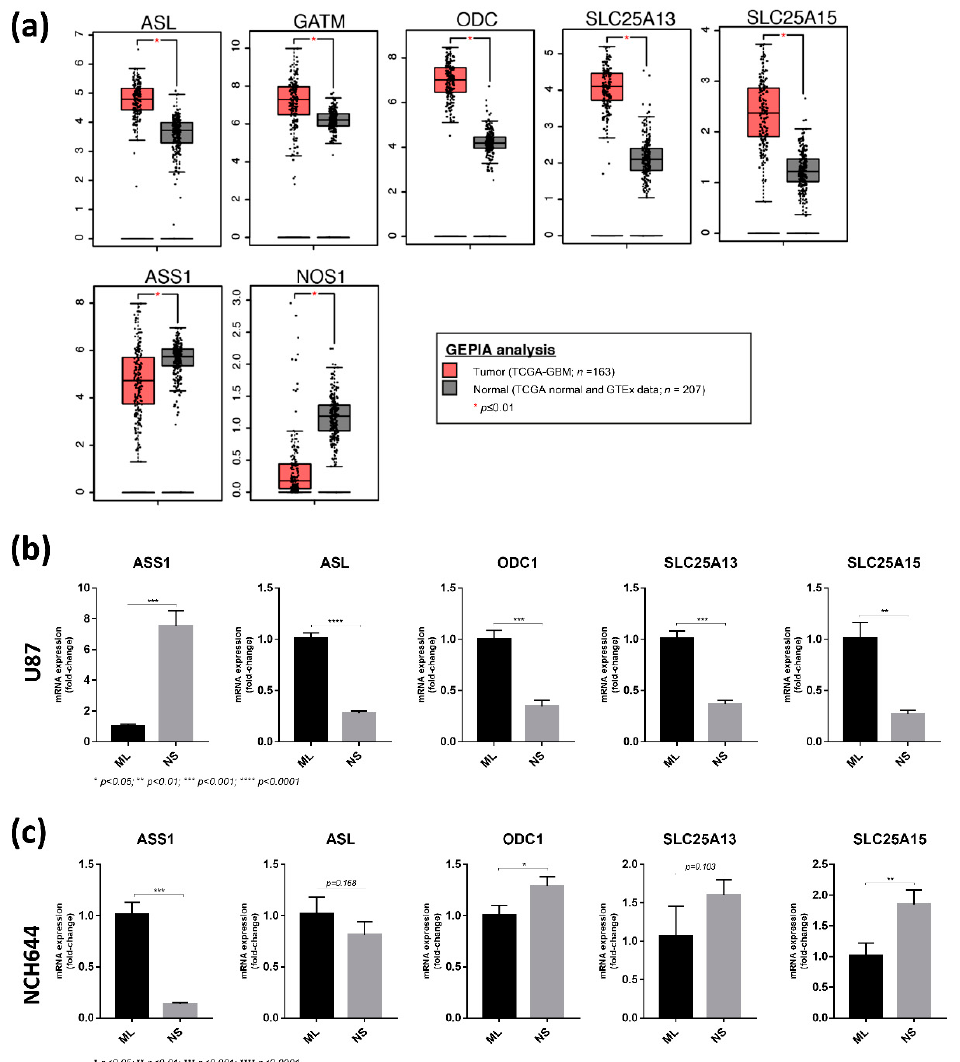
Figure 6. Expression analysis of arginine biosynthesis genes in NCH644 NS compared to ML cells may resemble human GBM tumours compared to normal tissue. ( a ) Expression data from human GBM tumours (TCGA-GBM; n = 163) and corresponding normal tissue (TCGA normal and GTEx data; n = 207) were accessed via the GEPIA tool (http://gepia.cancer-pku.cn/index.html, accessed on the 3 December 2020). Data were selected based on a log2-fold change cut-off of 1 and a p -value cut-off of 0.01. Only significantly altered genes are shown. ( b ) qPCR analysis of arginine biosynthesis genes in U87 ML and NS cultures. ( c ) qPCR analysis of arginine biosynthesis genes in NCH644 ML and NS cultures.